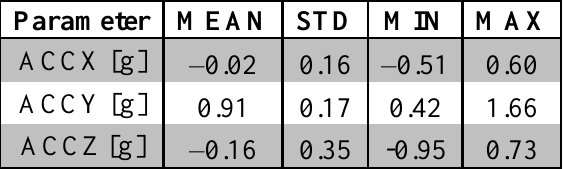
Table 5. Statistical analysis of experimental data acquired during 80 s digging a hole.